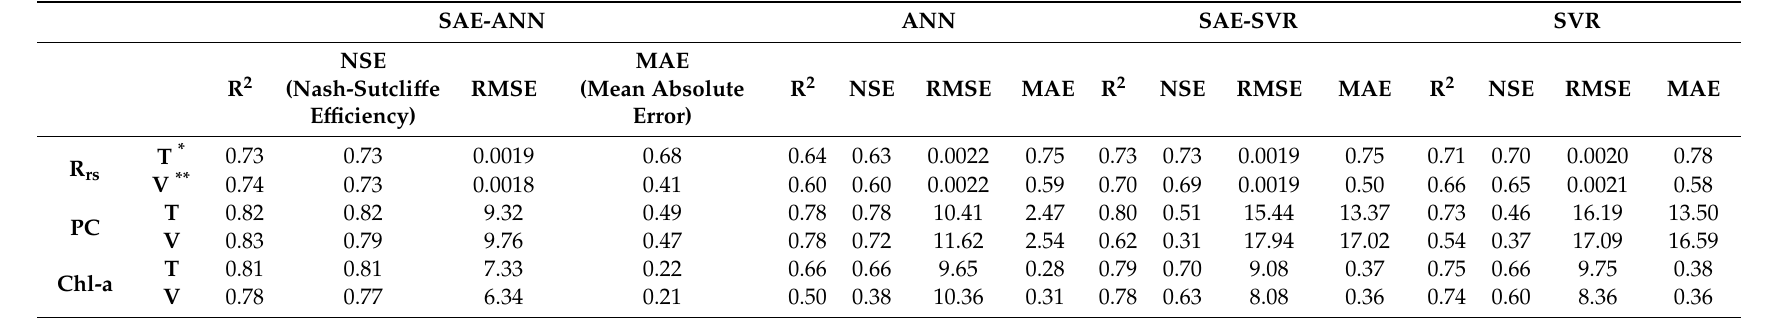
* indicates training result and ** represents validation